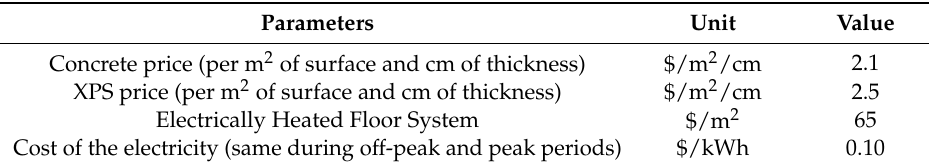
Table 8. Considered parameters to calculate the indicators. Parameters Unit Value Concrete price (per m 2 of surface and cm of thickness) $/m 2 /cm 2.1 XPS price (per m 2 of surface and cm of thickness) $/m 2 /cm Electrically Heated Floor System $/m 2 65 Cost of the electricity (same during off-peak and peak periods) $/kWh 0.10